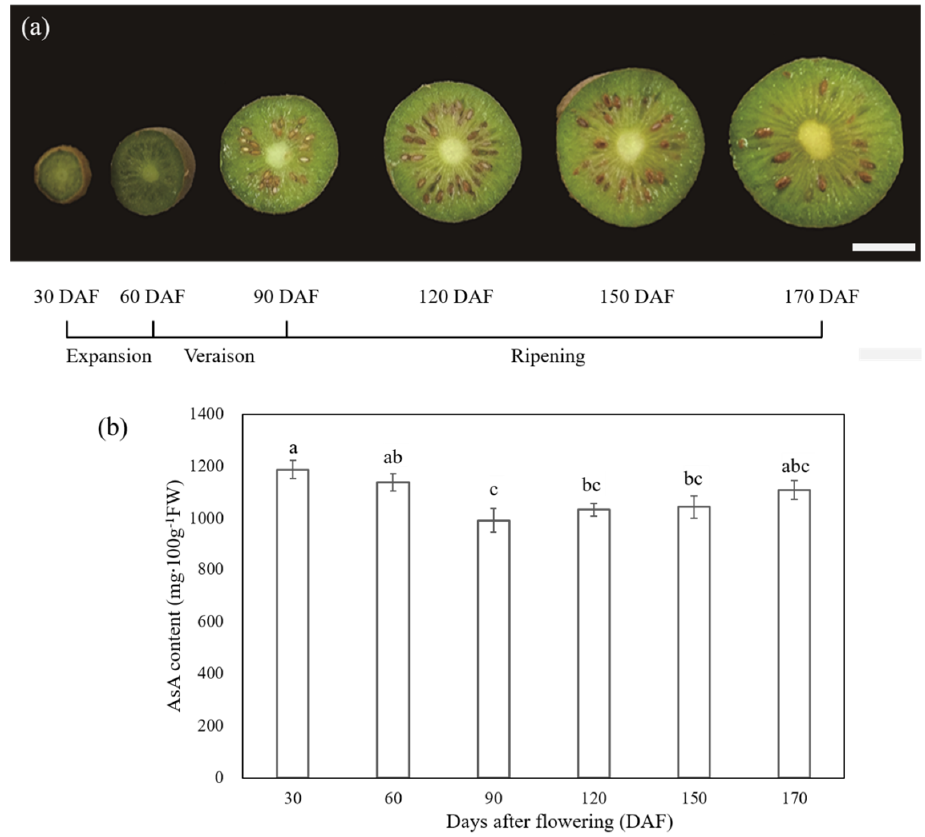
Figure 2. Phenotypic characterization ( a ) and AsA accumulation ( b ) of A. latifolia fruit development and ripening. The x-axis represents different stages of fruit development and ripening, which are expressed as days after flowering. The scale bar in ( a ) denotes 1 cm. Vertical error bars in ( b ) represent standard error (SE) of three biological replicates. The significance of differences ( p < 0.05) among samples were determined using ANOVA and Tukey’s HSD test. Different letters on the vertical bars indicate significant difference.